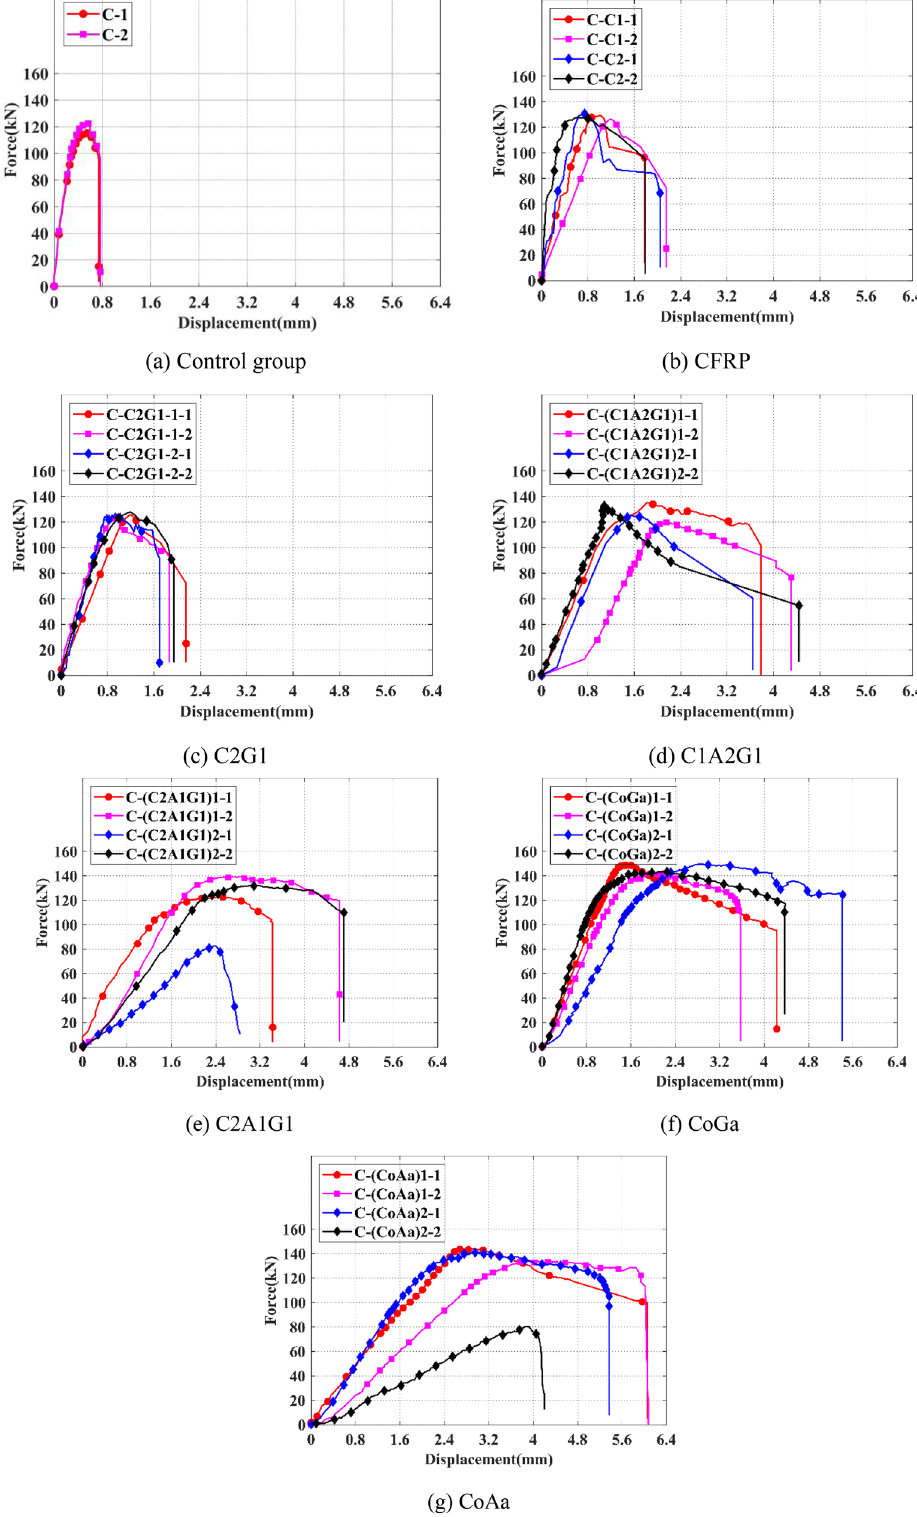
Fig. 12 Load–displacement curve of group